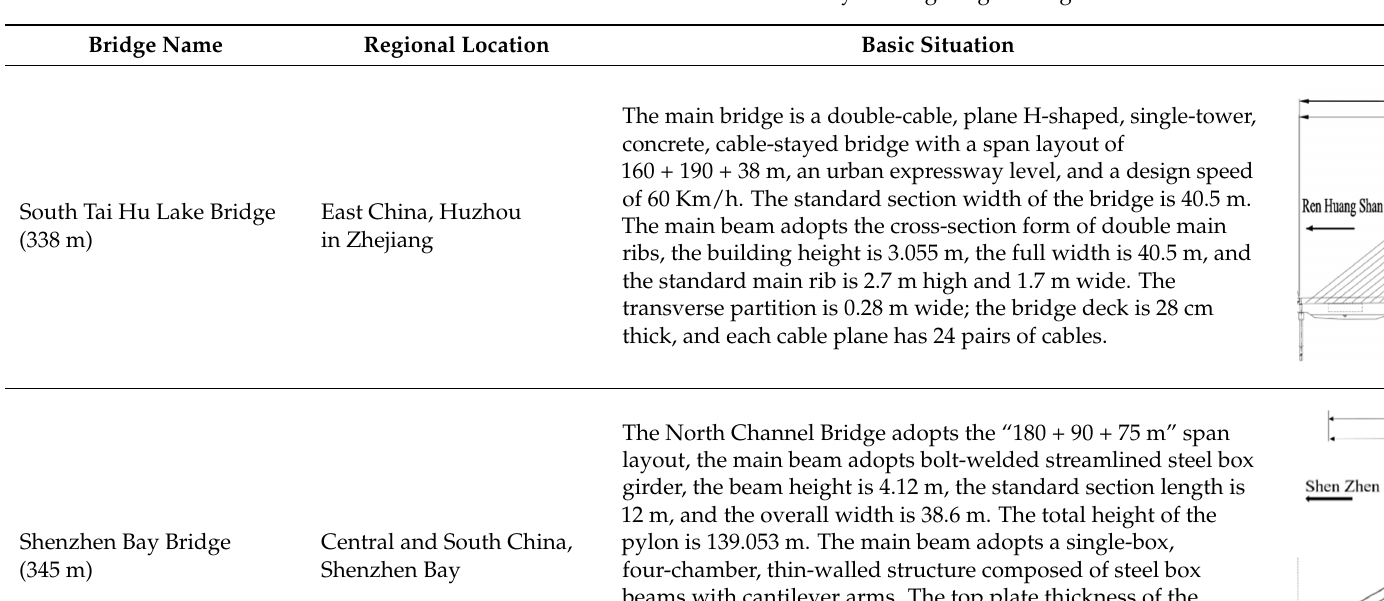
Table 3. Cable-stayed bridge engineering data statistics table.